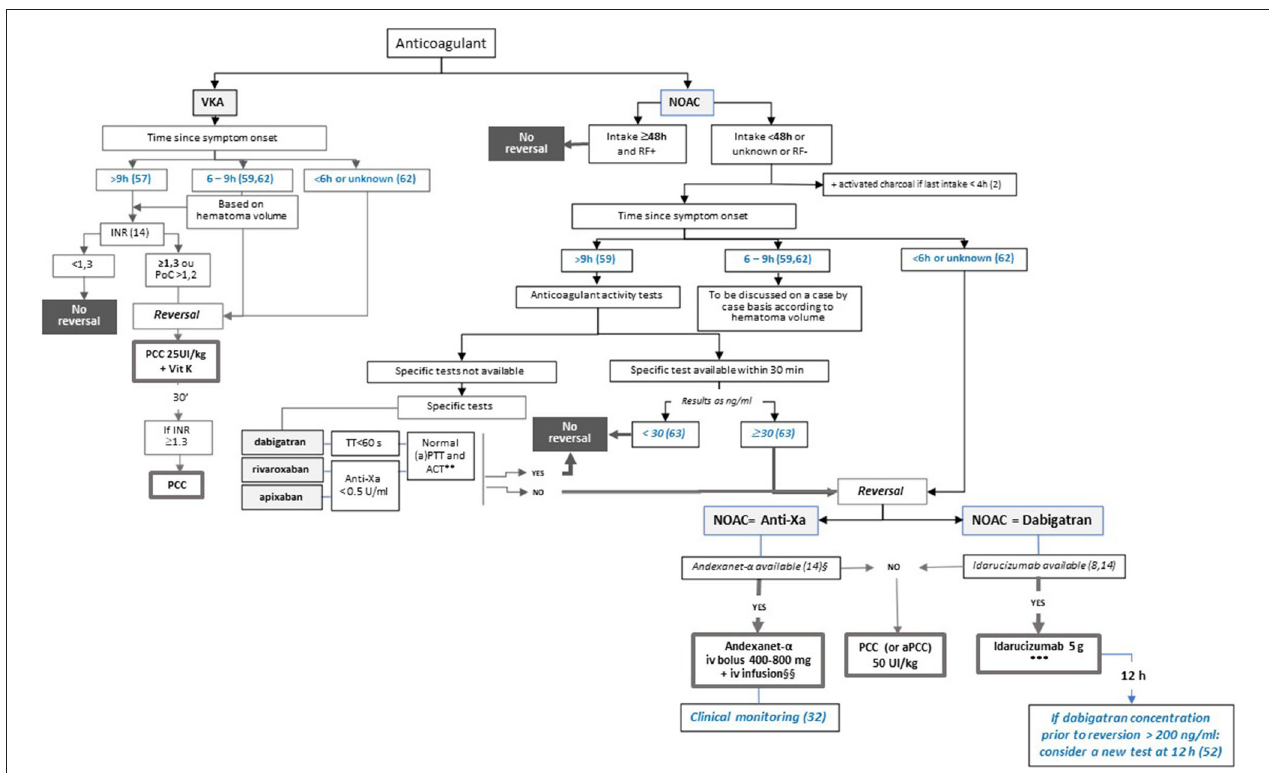
FIGURE 2 | Proposed algorithm for the management of intracerebral haemorrhage according to the anticoagulant, time since symptom onset, and local specificities. This figure presents the decision-making process for anticoagulant reversal in patients presenting with HIC in taking into account thresholds for the time since symptom onset according to Al-Shahi Salman and colleagues, 2018 ( 65) and to Kuramatsu and colleagues, 2015 (68). Steps in blue are based on data from the literature and are not mentioned in the current guidelines. *Dose to be determined according to INR. **For dabigatran and rivaroxaban. ***In case of high concentration of dabigatran ( > 200ng/ml) prior to reversal, consider assessment of anticoagulation activity 12h after reversal and, if dabigatran concentration > 50ng/ml, a second administration of idarucizumab. § Approved for apixaban and rivaroxaban. §§ In case of high concentration of apixaban or rivaroxaban ( > 200ng/ml) prior to reversal, consider assessment of anticoagulation activity according to clinical parameters. ACT: activated cephalin time; aPTT: activated partial thromboplastin time; IVT: intravenous thrombolysis; PCC: prothrombin complex concentrates; RF + /RF-: normal (creatinine clearance ≥ 50 ml/min) or abnormal renal function according to the last dosage available; TT: thrombin